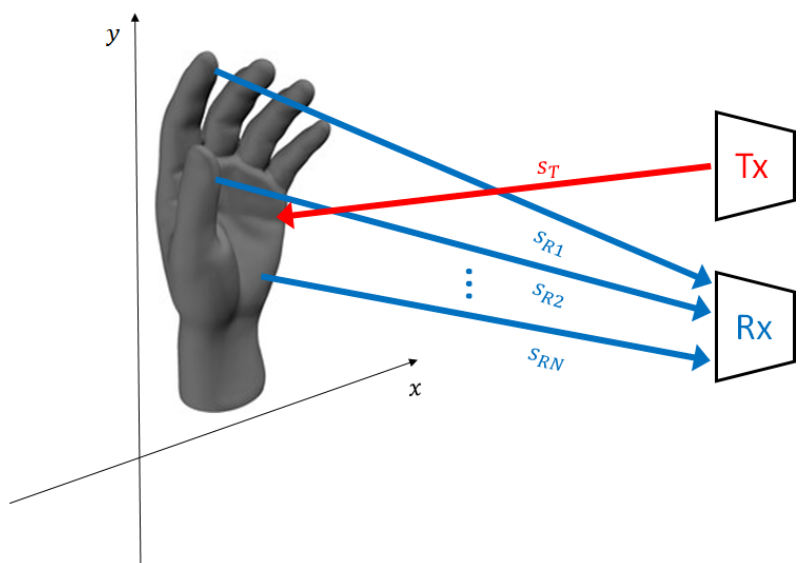
Figure 1. The signal back-scattered by the hand is an ensemble of multiple waves reflected by the different parts of the hand. Each one is characterized by its own amplitude and phase and, in case of a moving hand, Doppler